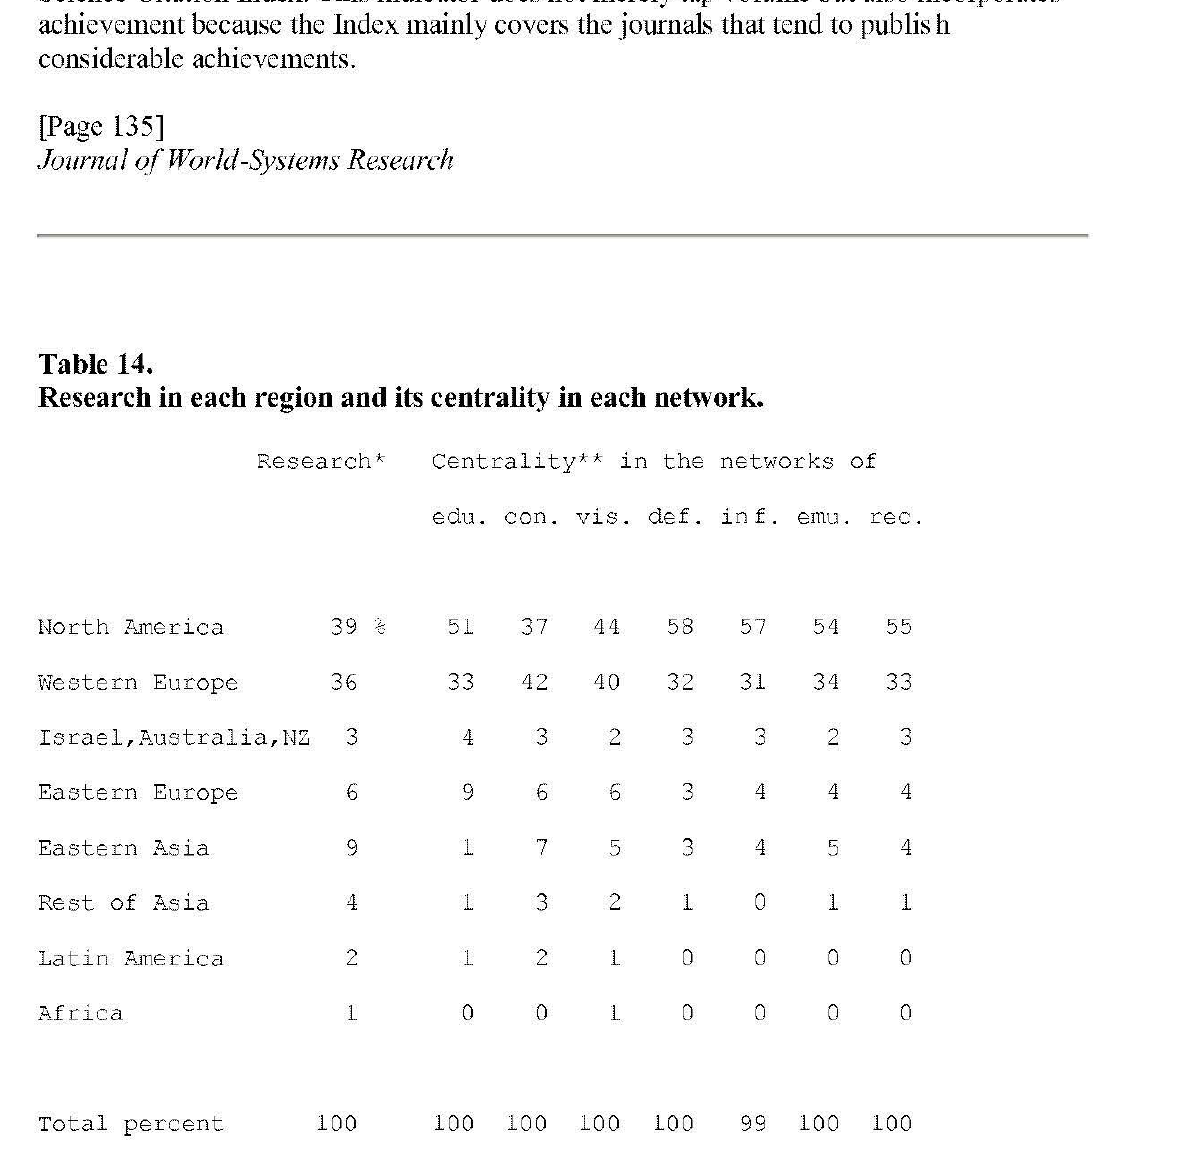
Research in each region and its centrality in each